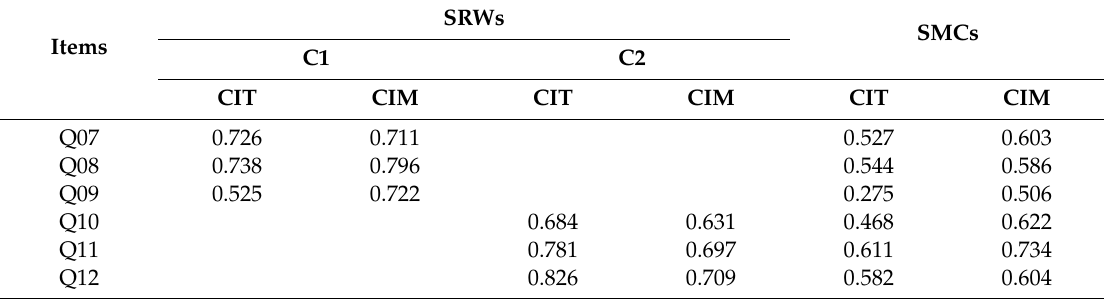
Table 18. SRWs and SMCs of the criteria related to project success (C1) and organization success